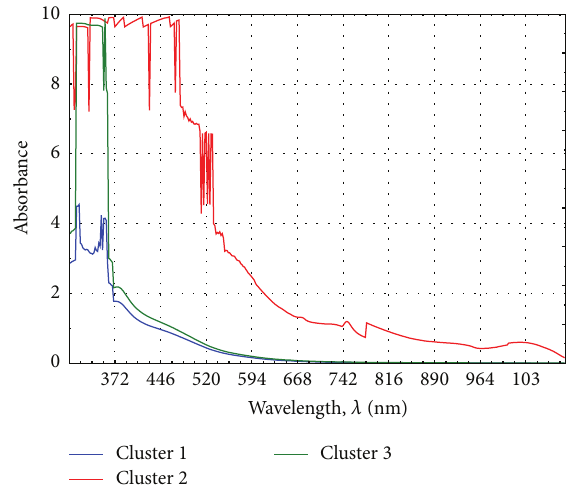
Figure 3: Chart of mean clusters containing spectra of dog rose